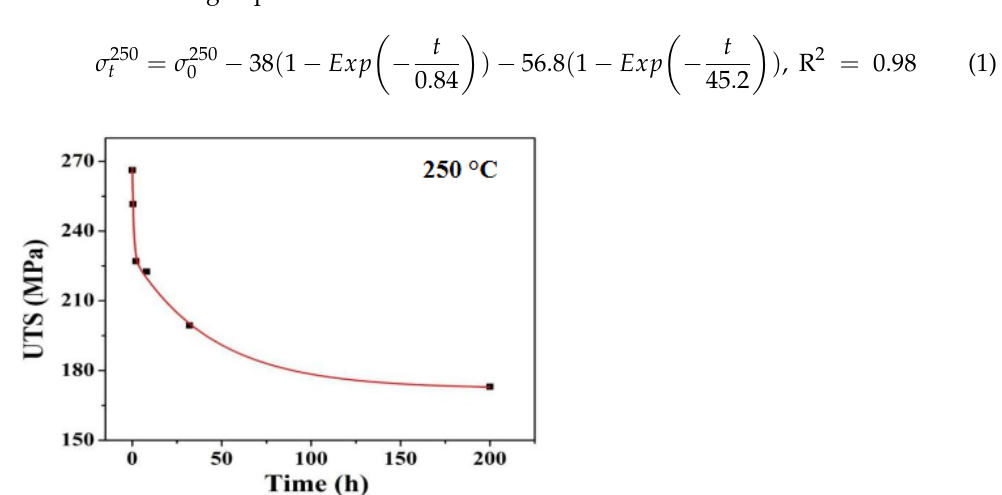
6 of 12 Figure 7. Tensile properties of the Al-Si-Cu-Ni-Mg alloy measured at different states (TE represents thermal exposure at 250 °C for 200 h). The UTS of the TE alloy dropped from 170.2 MPa to 120.2 MPa when the temperature was increased from 25 °C to 250 °C, which is a significant drop of 29.4%. The elongation of the TE alloy increased greatly from 0.39% to 0.92% when the temperature was increased from 25 °C to 250 °C. With a test temperature of 250 °C, dislocations can climb to a certain extent under the action of stress, which provides more possibilities for alloy cross-slip and reduces the resistance of the cross-slip process. The climbing of a dislocation leads to a